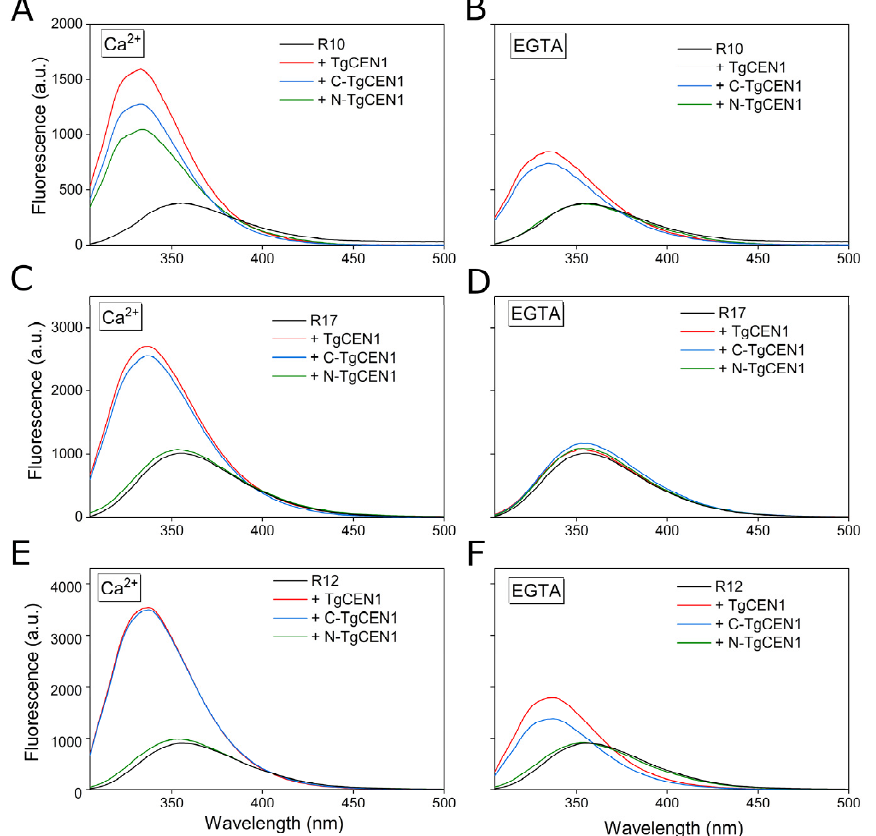
Figure 6. Binding of TgCEN1 and its domains to the different peptides in the presence of CaCl 2 or EGTA measured by Trp fluorescence. Trp fluorescence emission spectra of peptide alone (black line), and upon addition of intact TgCEN1 (red line), C-TgCEN1 (blue line), or N-TgCEN1 (green line) in the presence of CaCl 2 ( A , C , E ) or EGTA ( B , D , F ).